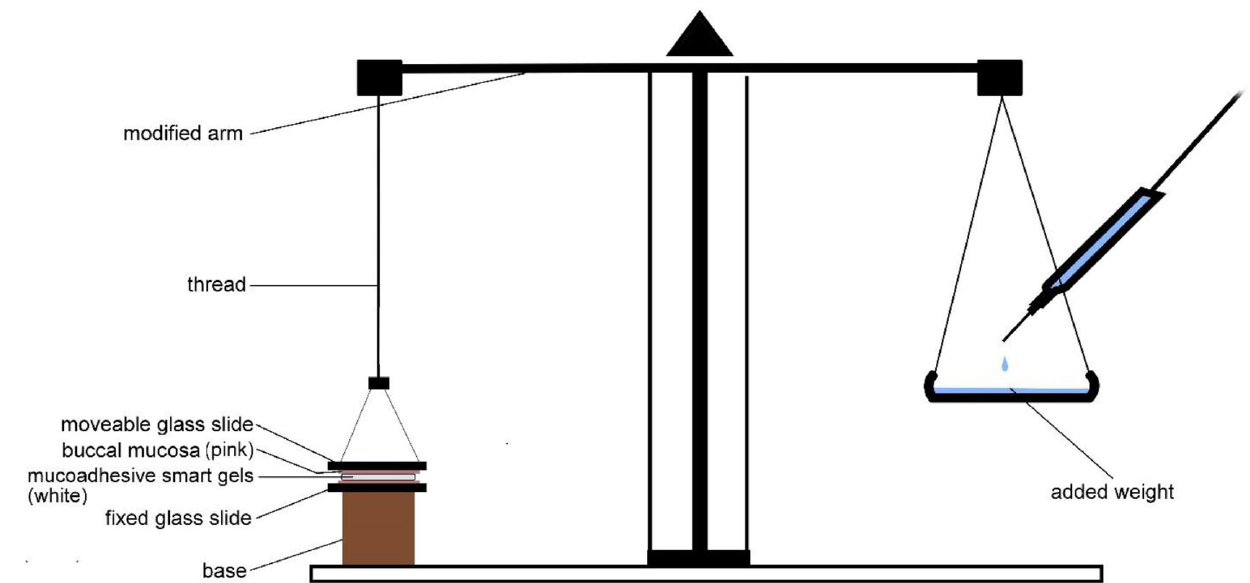
Figure 1. Modified physical balance for the estimation of ex vivo mucoadhesive strength as re- ported [16].